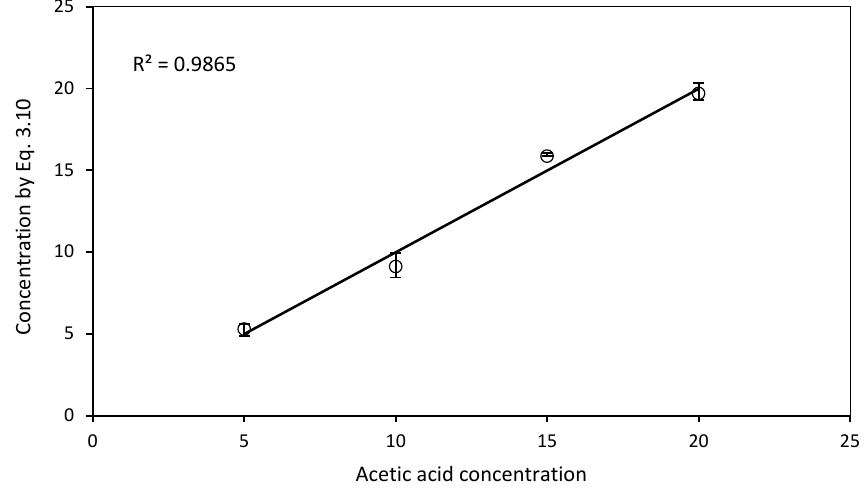
Figure 5. Graph of the real concentrations of acetic acid versus the estimated ones by Equation (4).